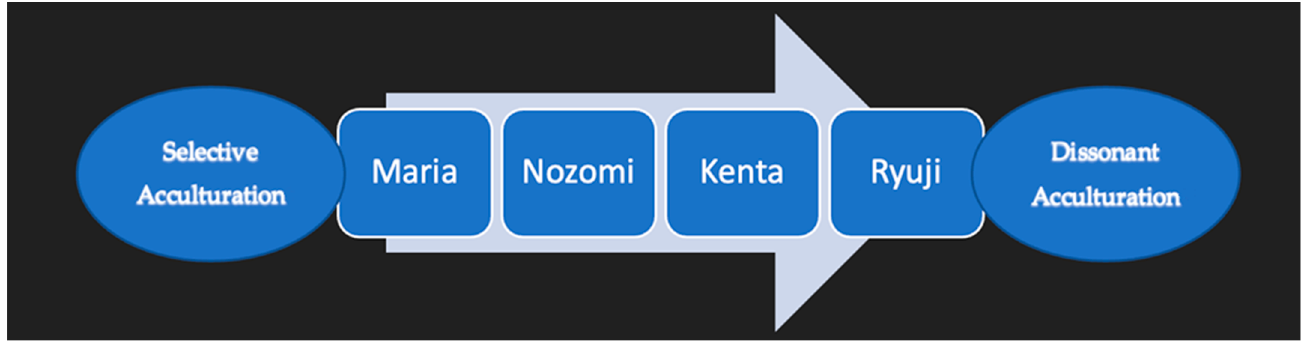
Figure 1. Selective–Dissonant Acculturation Spectrum.